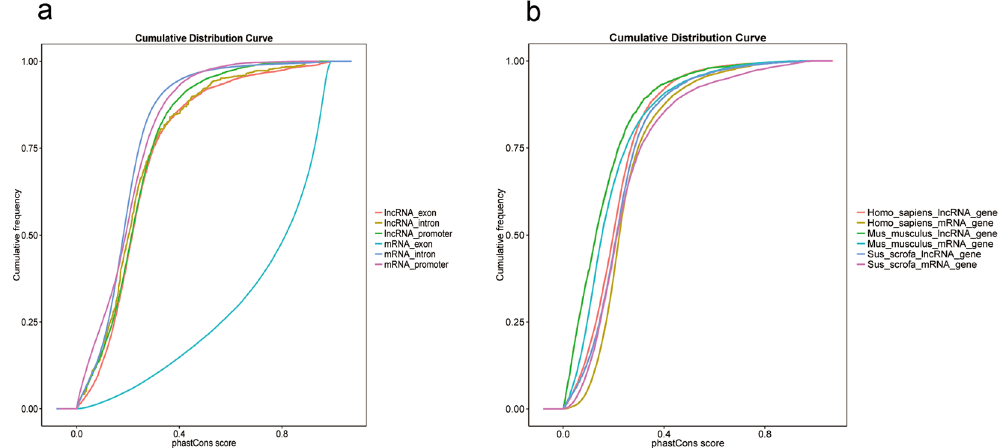
Figure 4. Conservation analysis of lncRNAs and mRNAs. PhyloFit was used to compute phylogenetic models for conserved and non-conserved regions among species. The model and HMM transition parameters were then input into phyloP to compute a set of conservation scores for lncRNA and coding genes. ( a ) Conservation scores of different regions of porcine lncRNAs and mRNAs identified in RNA-seq. ( b ) Conservation score of human, mouse, and porcine lncRNAs and mRNAs.